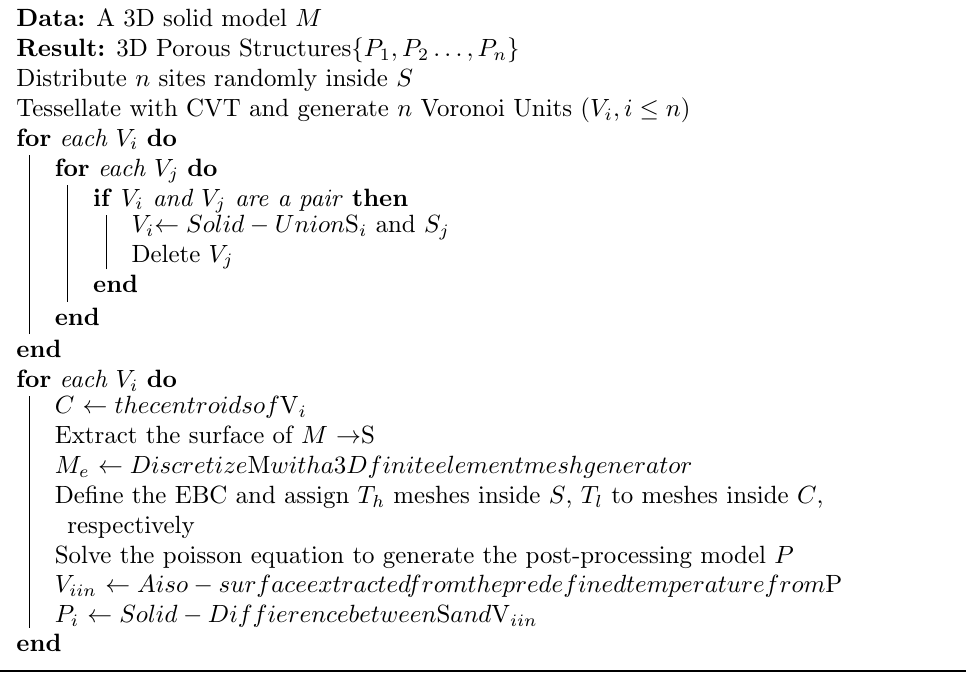
Algorithm 1: Porous Structure Modeling Method. Data: A 3D solid model